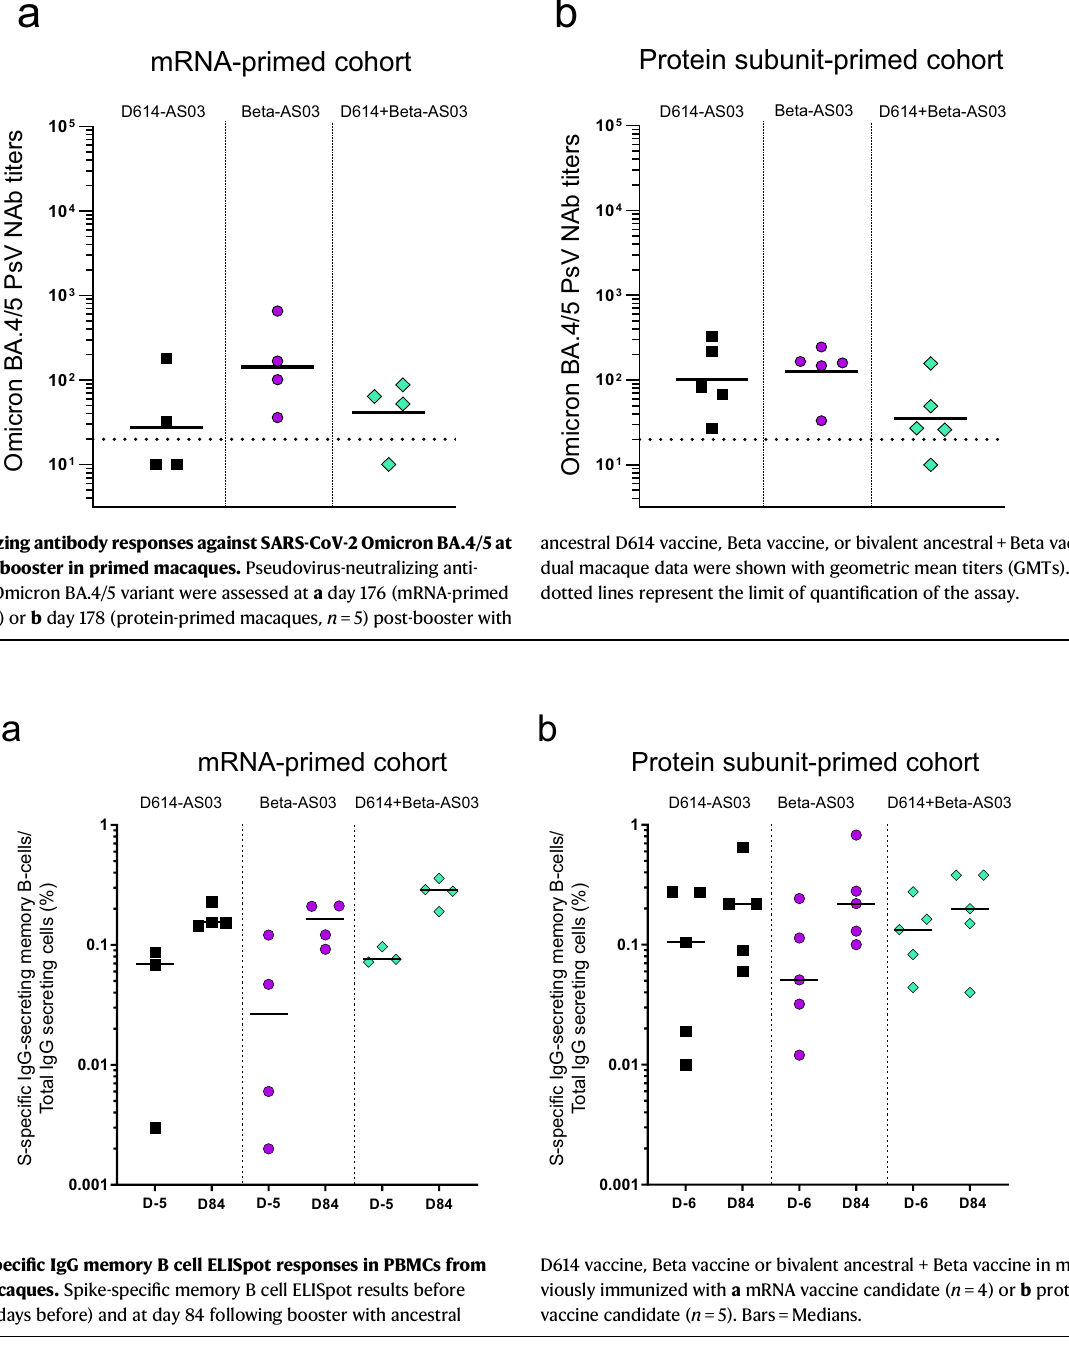
AS03 showed lower immunogenicity against Omicron BA.4/5 in both cohorts, probably due to a lower antigen dose (2.5 µ g).